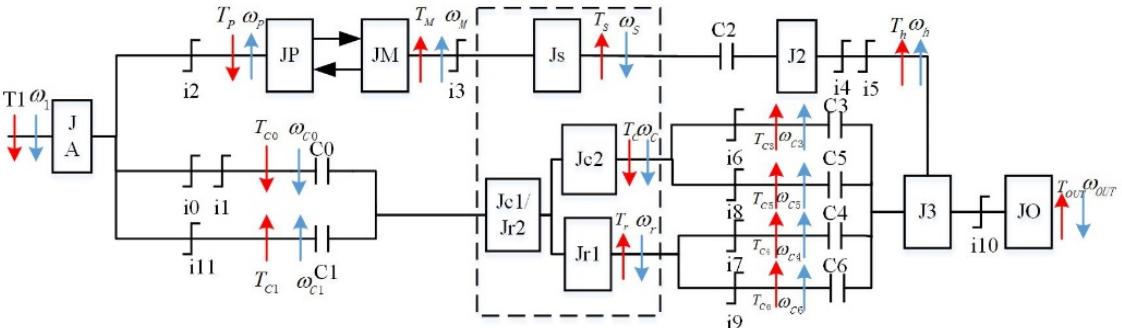
Figure 3. Dynamic model of HMCVT shafting (i1, i2, i3, . . . i11 represent different gear pairs; P represents the variable pump; M represents the fixed motor).